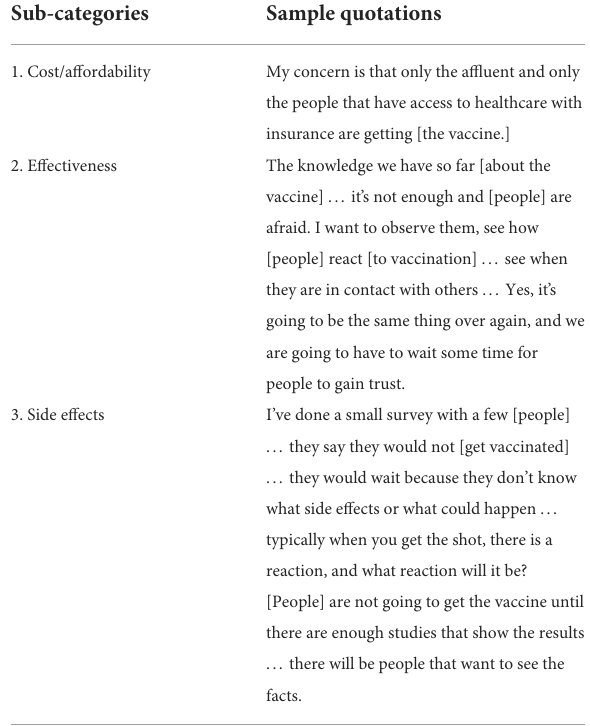
TABLE 3 Vaccine-related concerns as barriers to vaccination for COVID-19 according to community health workers/ Promotor/as .